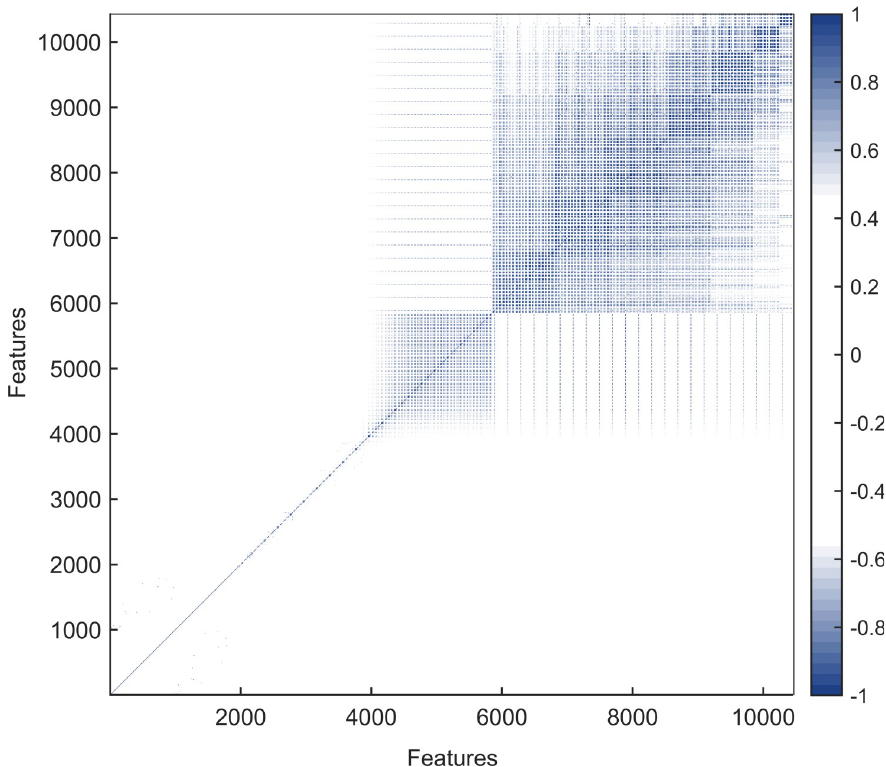
Fig 3. Correlation of all features. The correlation between all features obtained by calculating the Pearson correlation coefficient.